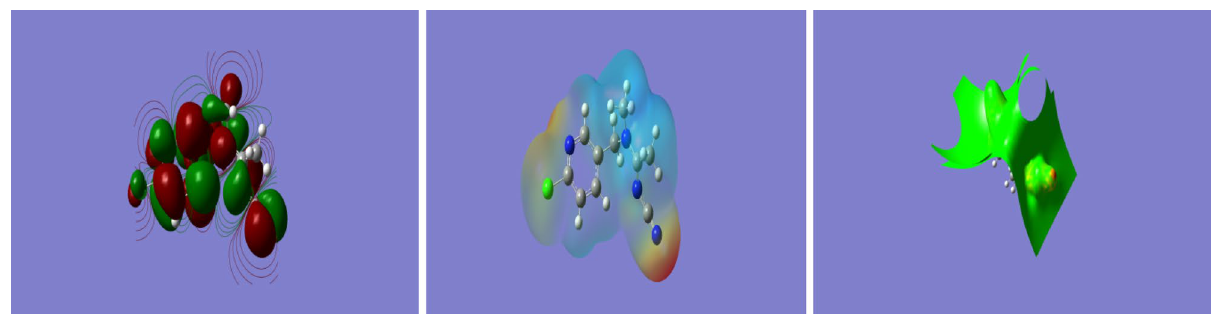
Figure 15. Acetamiprid electrostatic potential contours.